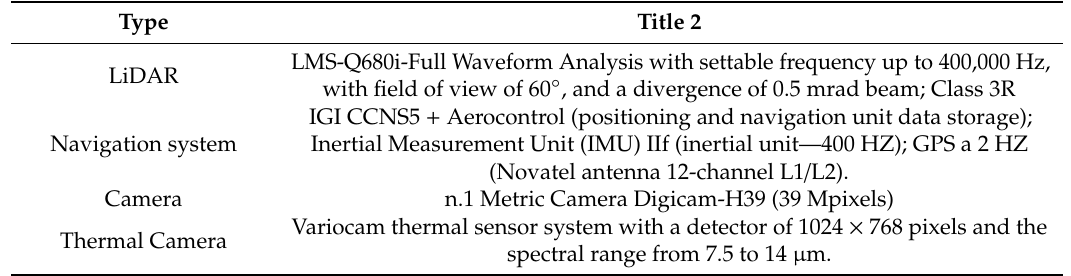
Table 2. Instrument mapping list used for LiDAR point cloud acquisition.